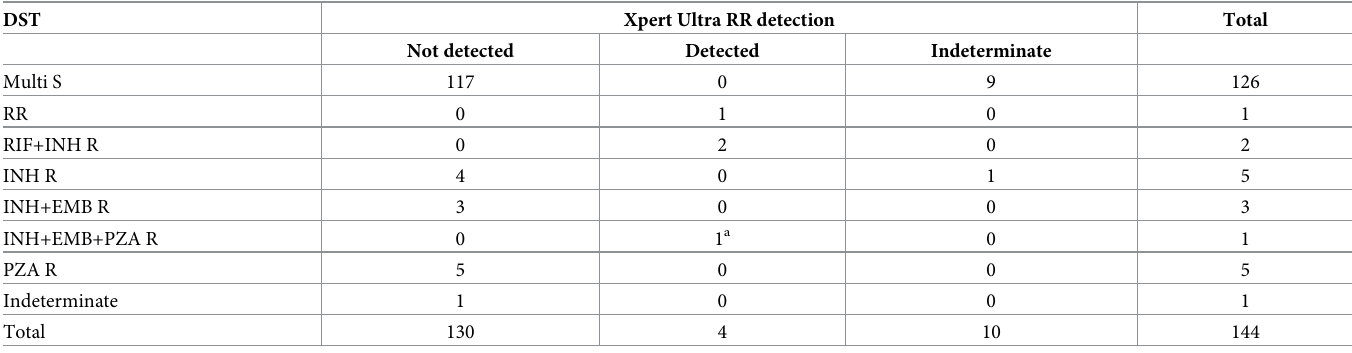
Table 4. RR assay results of Xpert Ultra compared to